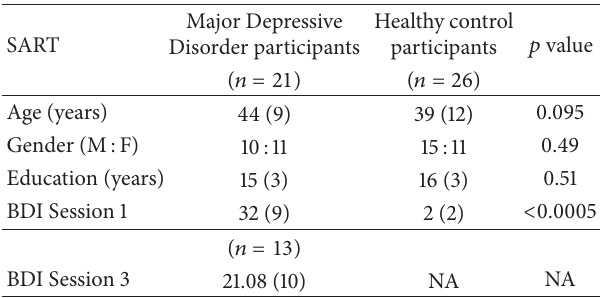
Table 1: Description of demographic and clinical data of partici-